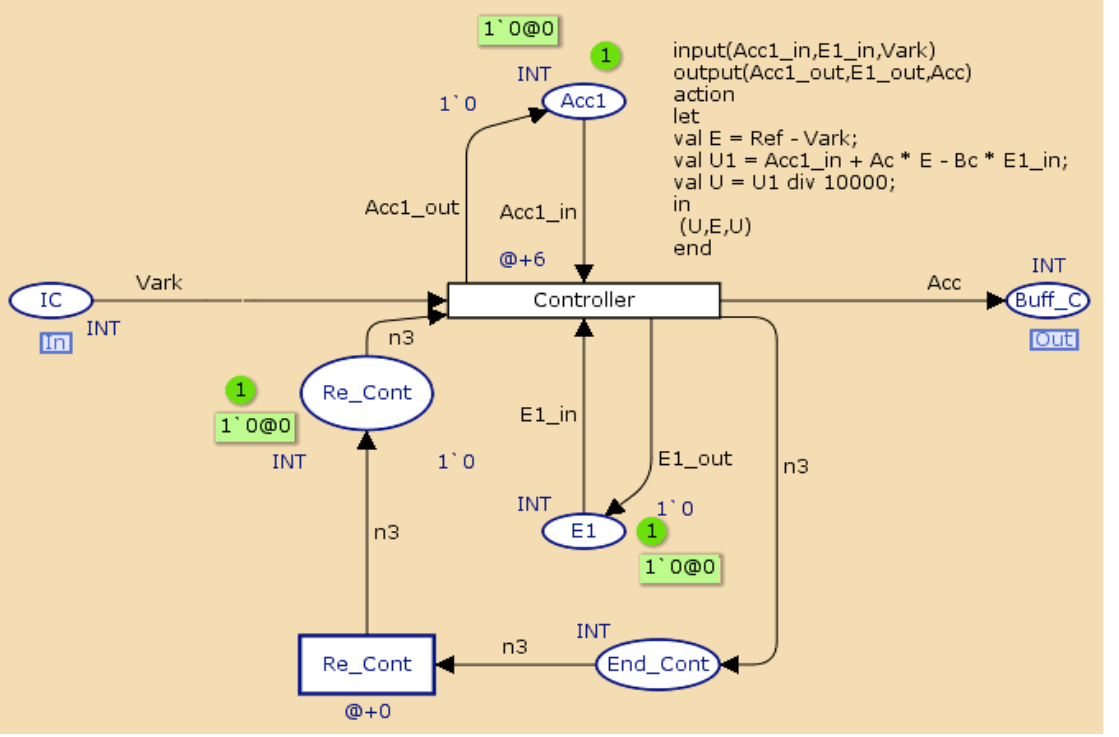
Figure 10. CPN model of the Controller